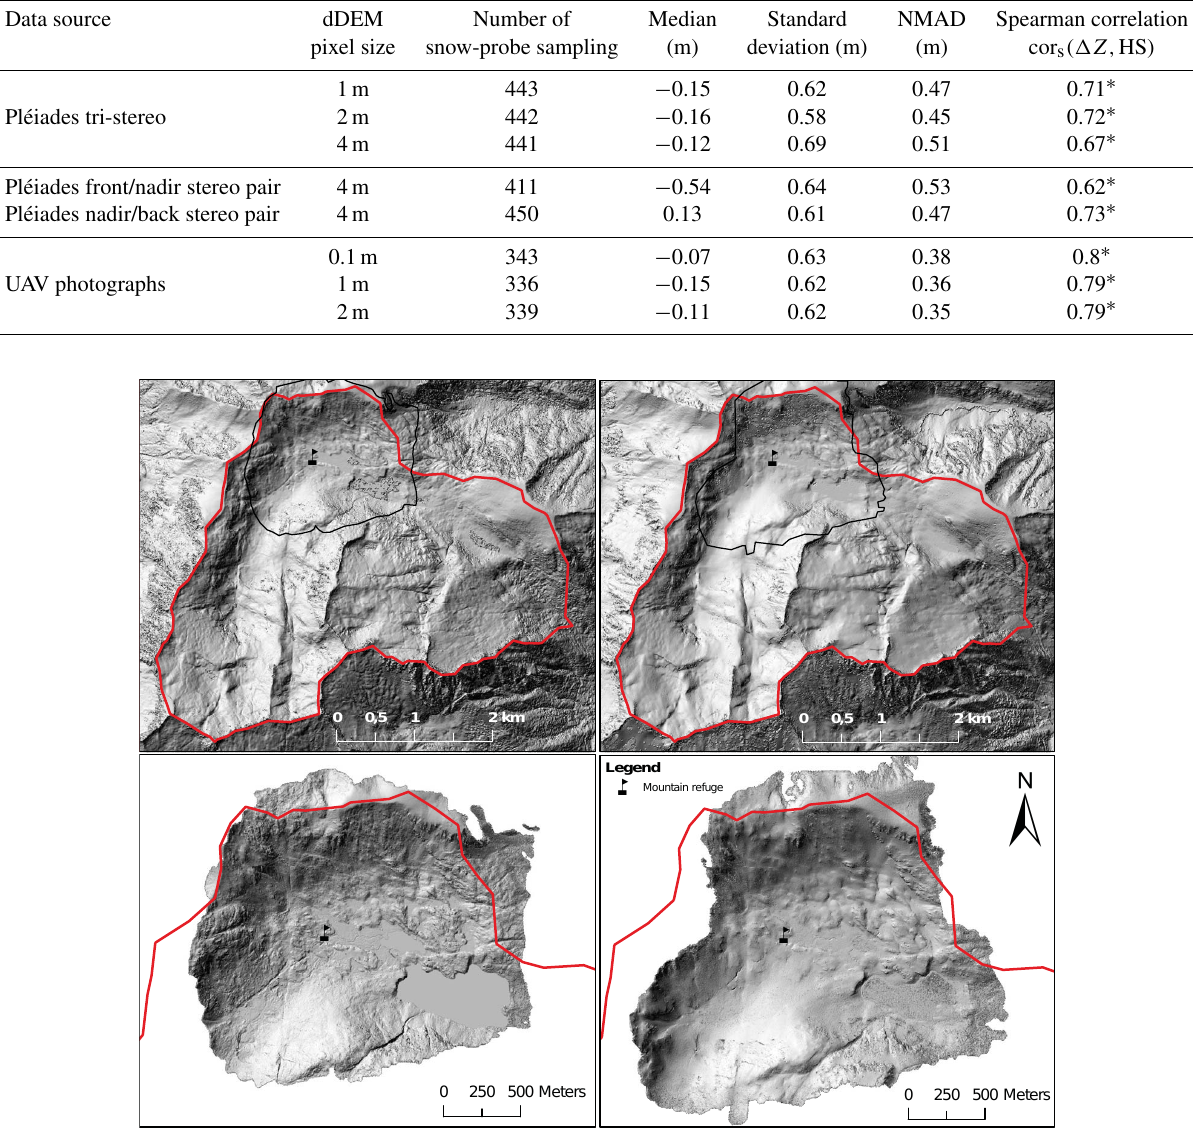
Table 4. Statistics relative to the comparison between the Pléiades and the UAV dDEMs to the snow-probe measurements, according to the pixel resolution. Significant correlations ( p values < 0.05) are marked with asterisks. NMAD means normalized median absolute deviation (Höhle and Höhle, 2009).